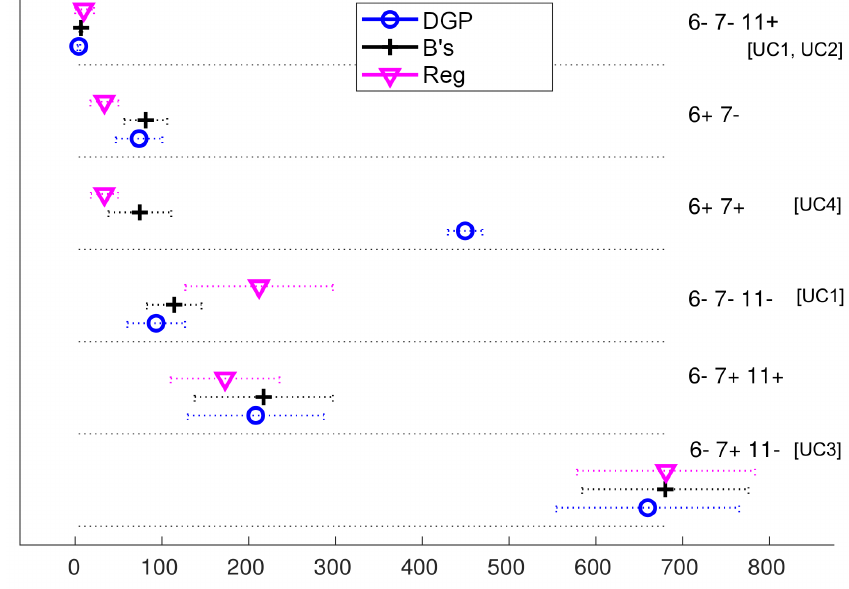
Figure 2. On the right side, from top to bottom, the six distinctive behaviours—clusters of scenarios—found for the M 1 ( α R − entry ) measure, arranged in six rows. The abscissa is the magnitude of that measure (number of iterations of the methods before entering steady-state). Each method within a behaviour has a point marker with its average value in the measure and ± 1 σ intervals around it (only illustrative of the dispersion, due to skewness). The lower the values, the better. The behaviours are labelled with the sets of scenarios that produce them (axes at their minimum extreme ( − ) or at their maximum (+) in all scenarios of the cluster). In square brackets, we also indicate the practical use cases that match the behaviours, from the ones described in Section